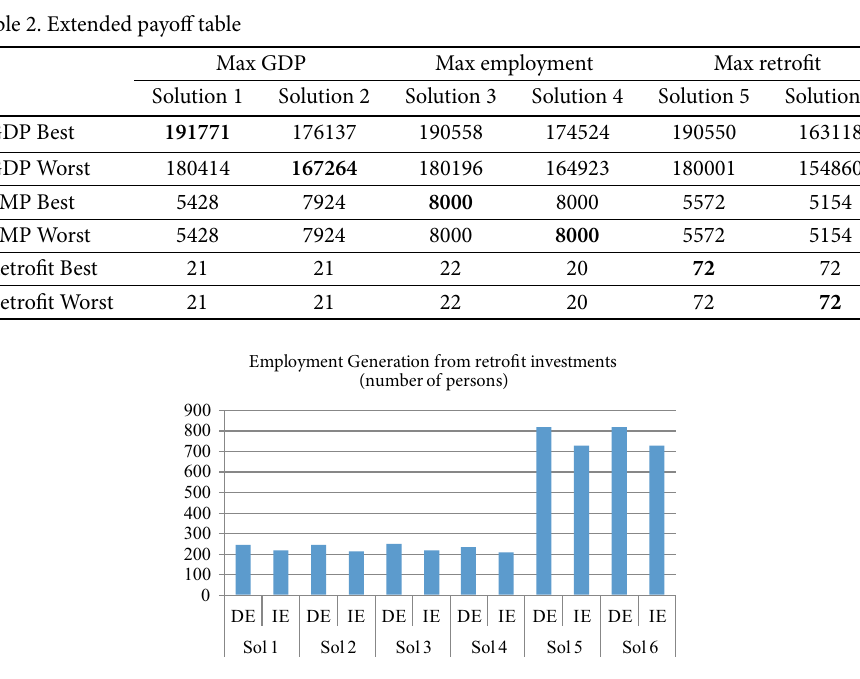
Fig. 3. DE and IE employment from retrofit